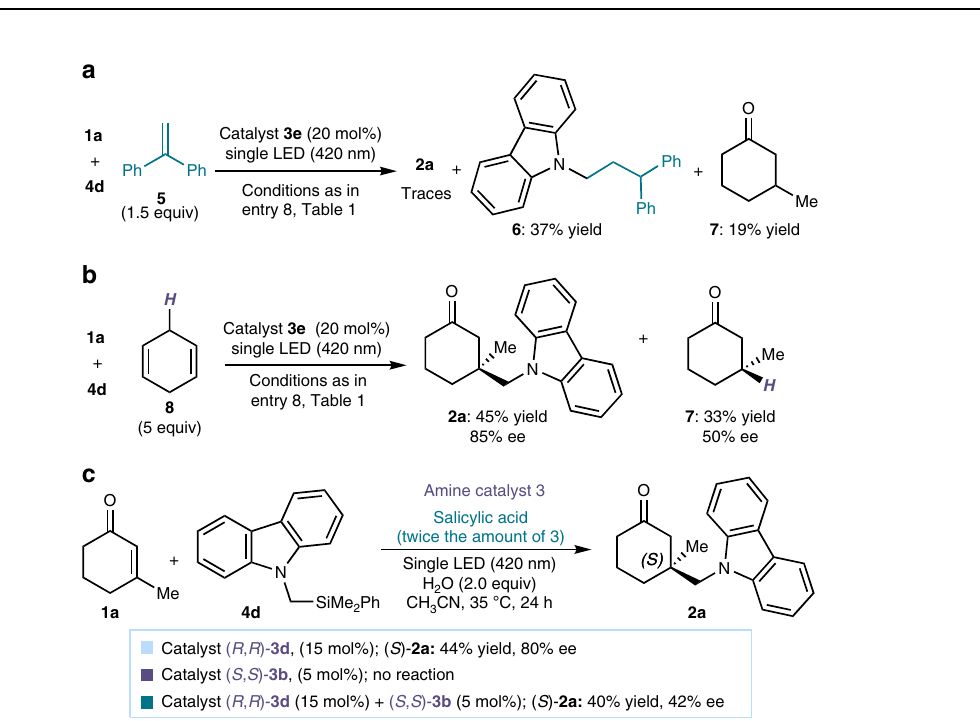
Fig. 4 Mechanistic investigations. a Trapping the radical intermediate generated from 4d . b The presence of an hydrogen donor 8 favors the formation of